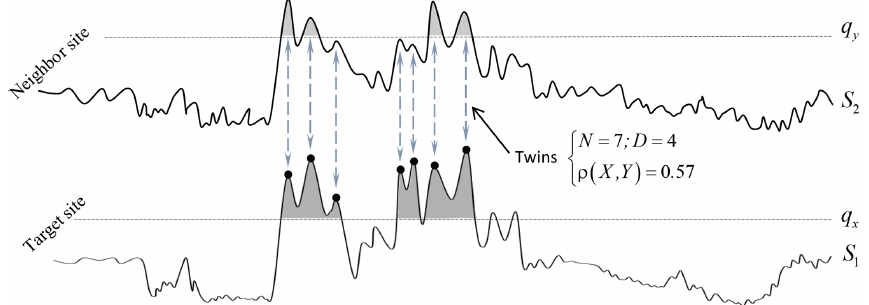
Figure 1. An illustrative example on how the extremal dependence coefficient is empirically computed. Among the seven extreme twins ( N = 7), only four overlapped with the target-site extreme storm surges ( D = 4). The extremal coefficient is then equal to